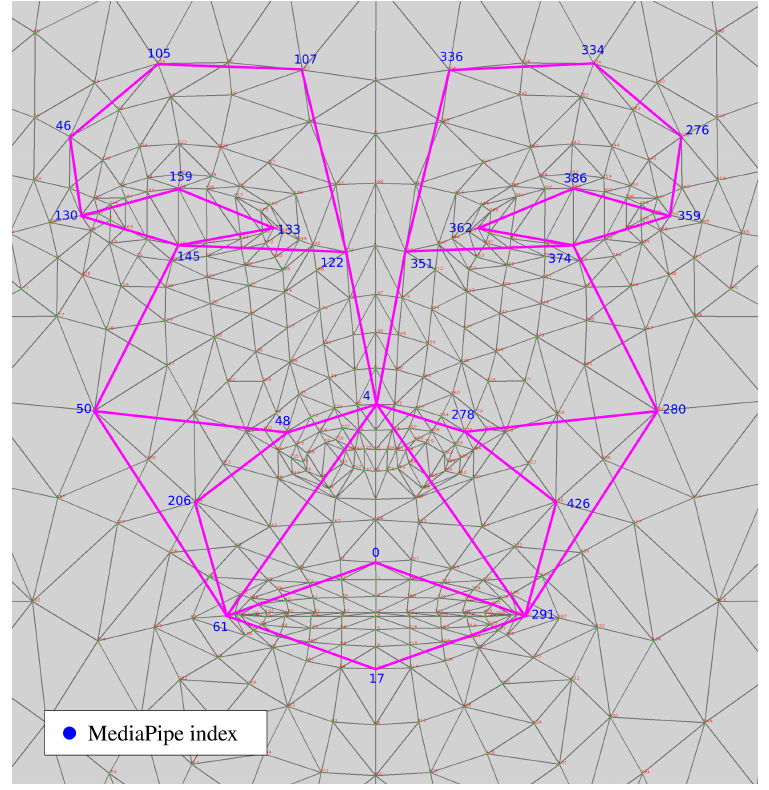
Figure 2. Emotional mesh proposed in [26].